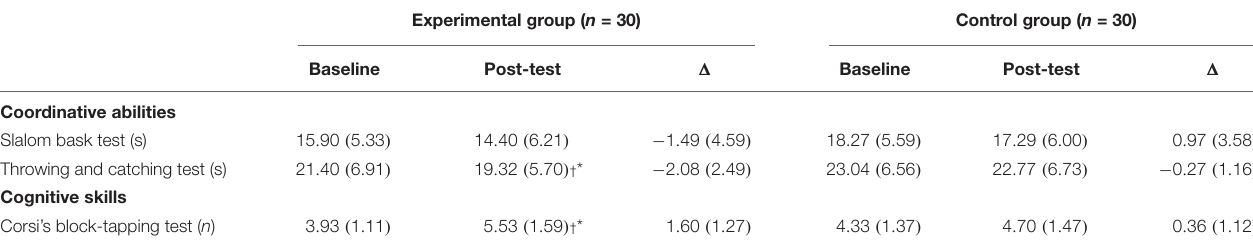
TABLE 1 | Changes after 12-week coordinative abilities training